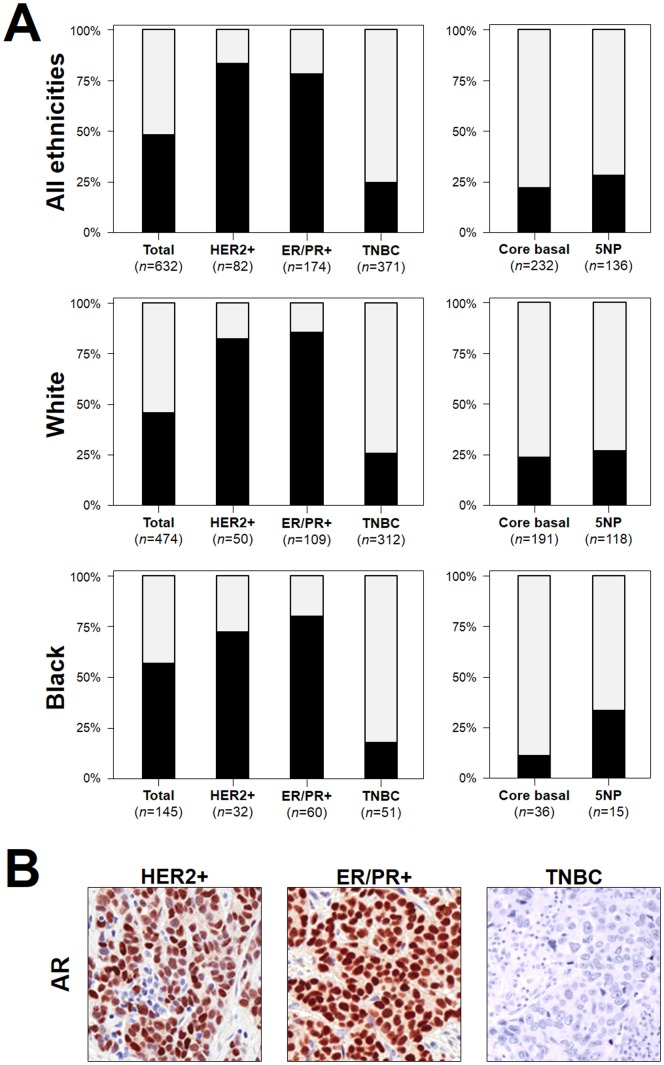
Androgen receptor expression is low in TNBC cases.AR expression distribution in the considered cancers. (A) Nuclear AR staining was significantly lower in TNBC specimens than in HER2-positive and ER/PR-positive tissues (p < 0.001). The trend toward expression differences among different ethnicities was not significant. Among TNBCs, 5NP cancers showed a higher frequency of AR expression (p = ns). Numbers represent TMA cores available for the analysis. Black  =  AR positive cases, gray  =  AR negative cases. (B) Representative images of AR immunostaining in the three cancer subtypes (HER2-positive, ER/PR-positive, and TNBC). (Original magnification, 200×)